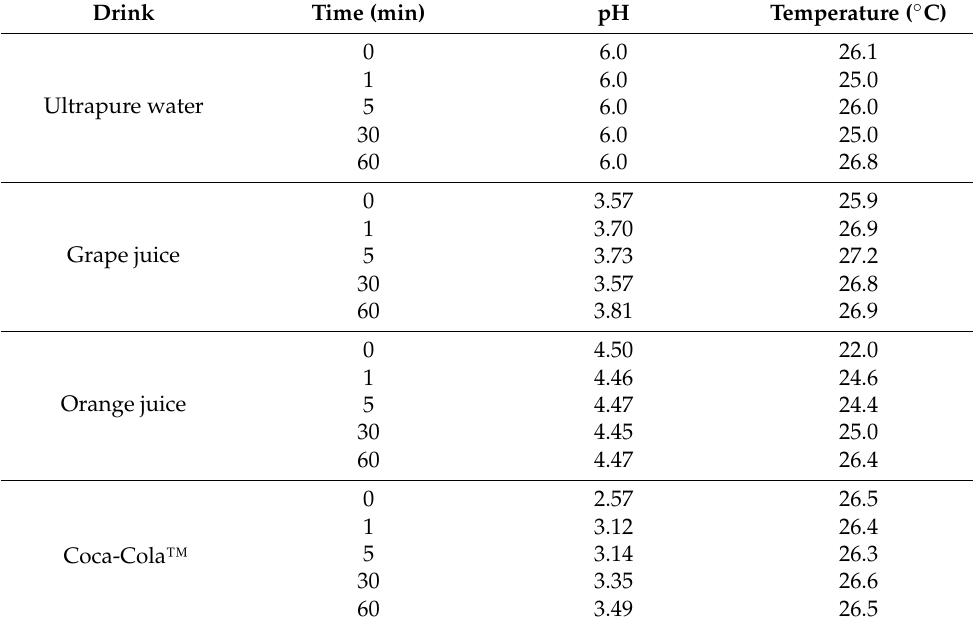
Table 1. Measurements at pH values and temperatures according to each drink’s exposure time before (t = 0) and after the erosive challenge (1, 5, 30, and 60 min). Drink Time (min) pH Temperature ( ◦